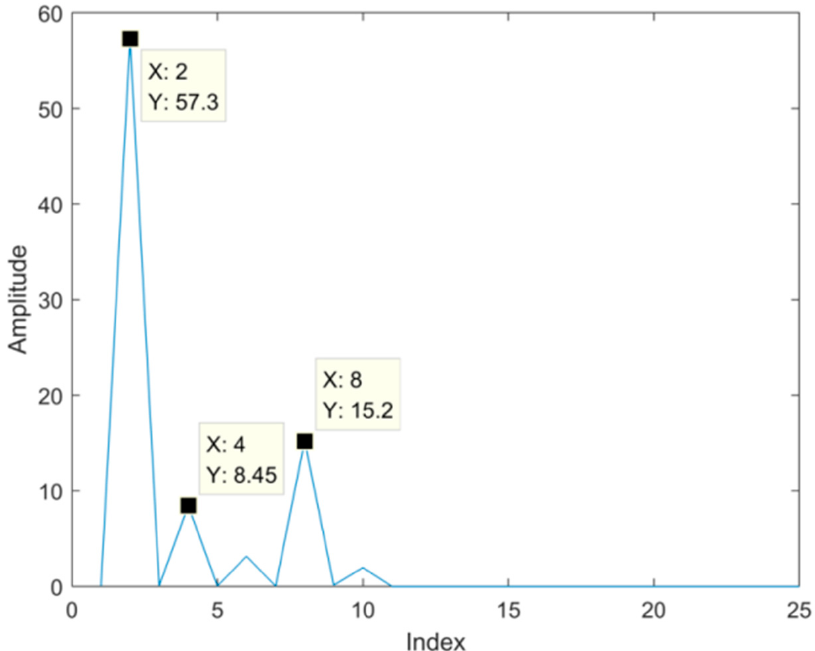
Figure 4. Difference spectrum of singular values.